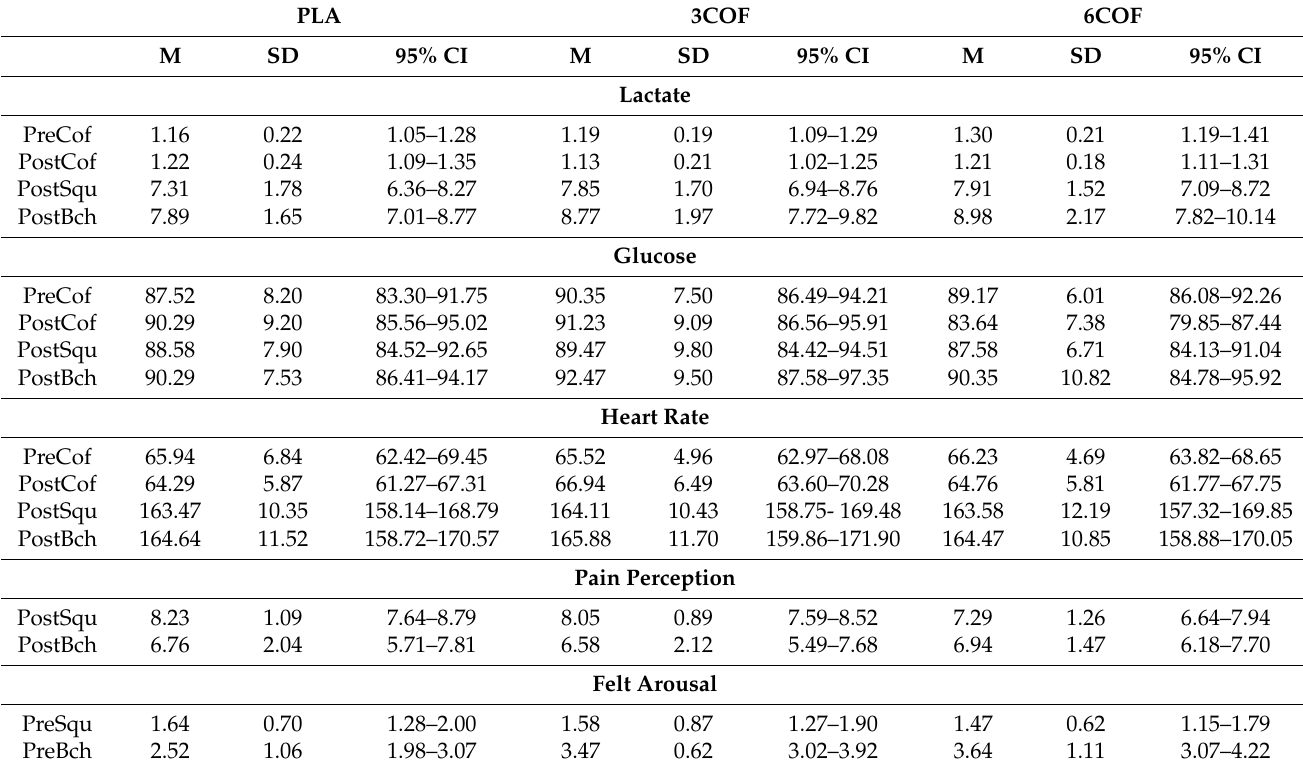
Table 4. Lactate, Glucose, Heart Rate, Pain Perception, Felt